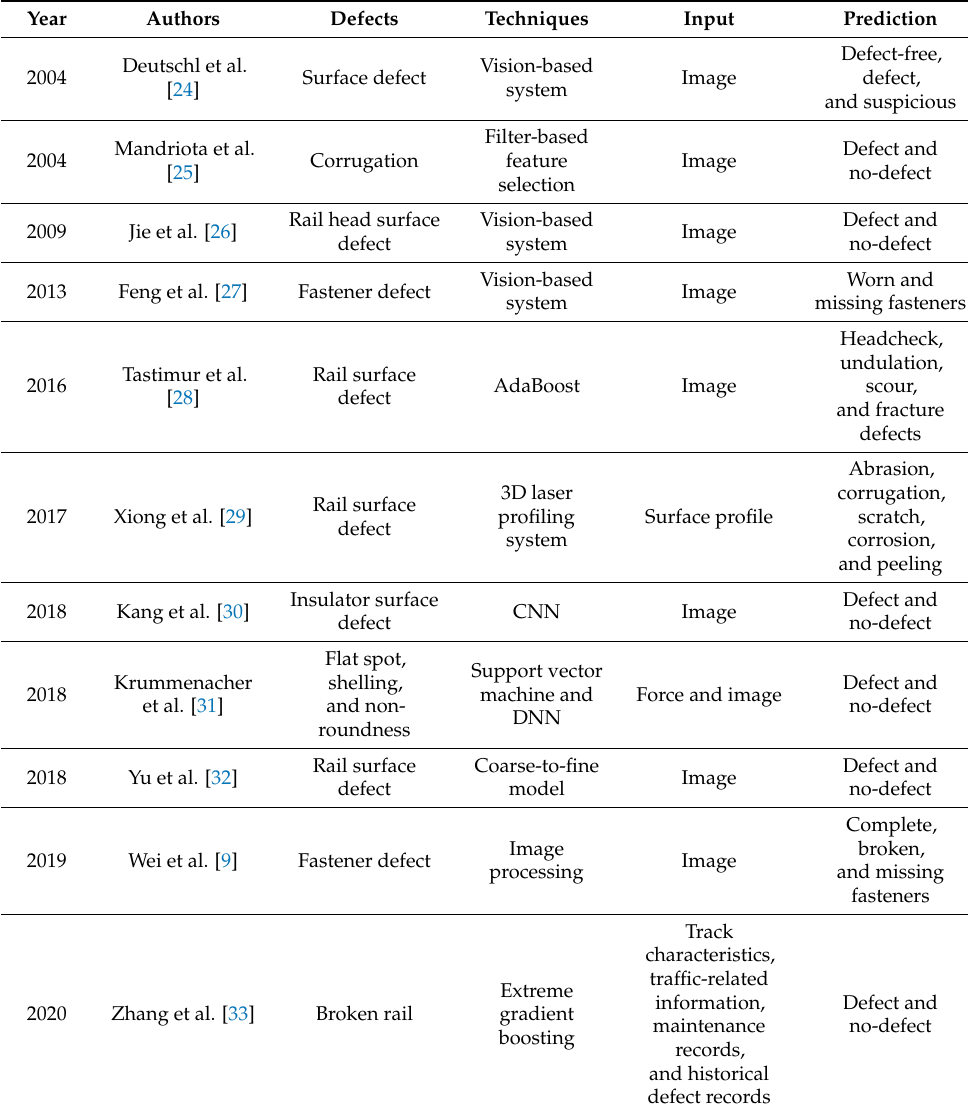
Table 1. Summarized list of studies using machine learning to detect railway